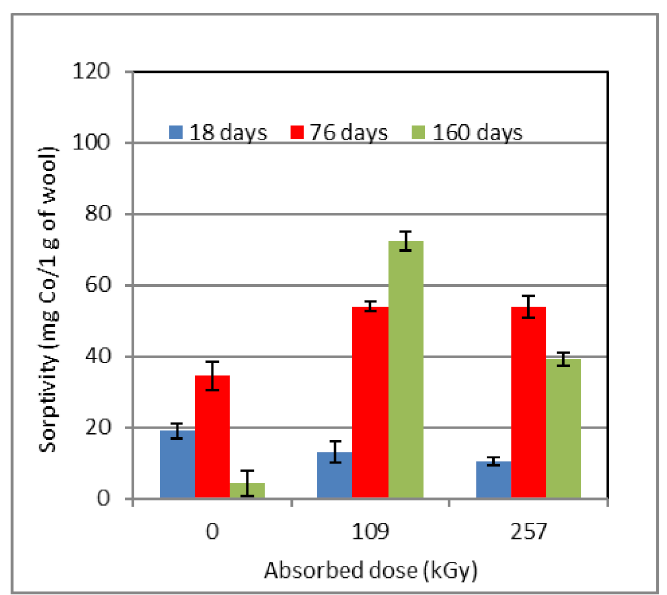
Figure 5. Time sorptivity variation with absorbed dose for wool pre-conditioned at 10% RH.